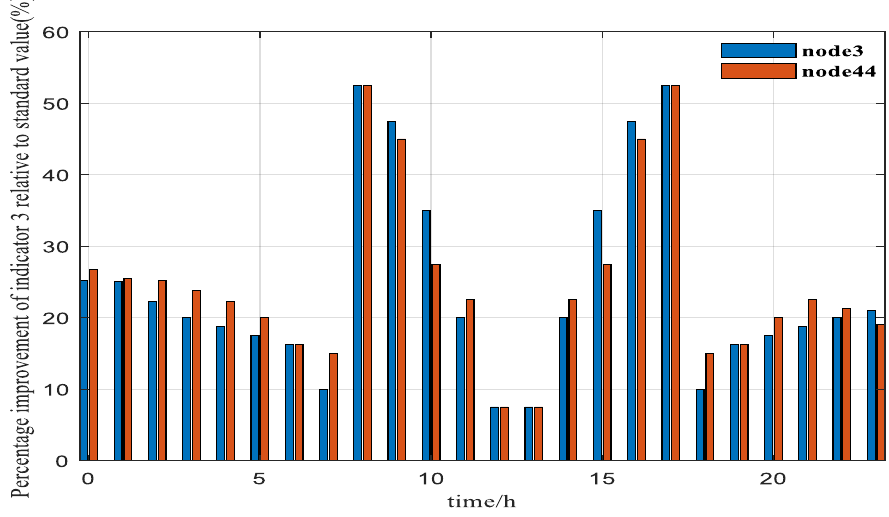
Figure 15. Percentage improvement of voltage fluctuation relative to the standard value.